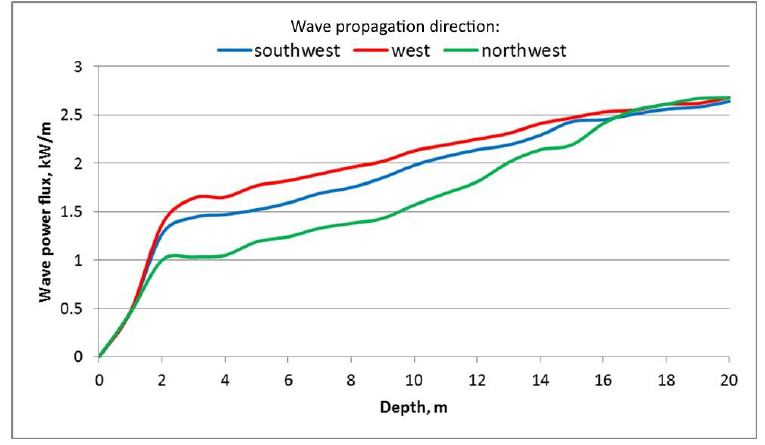
Figure 6. The impact of decreasing depth on wave power flux for a 1.25 m wave.